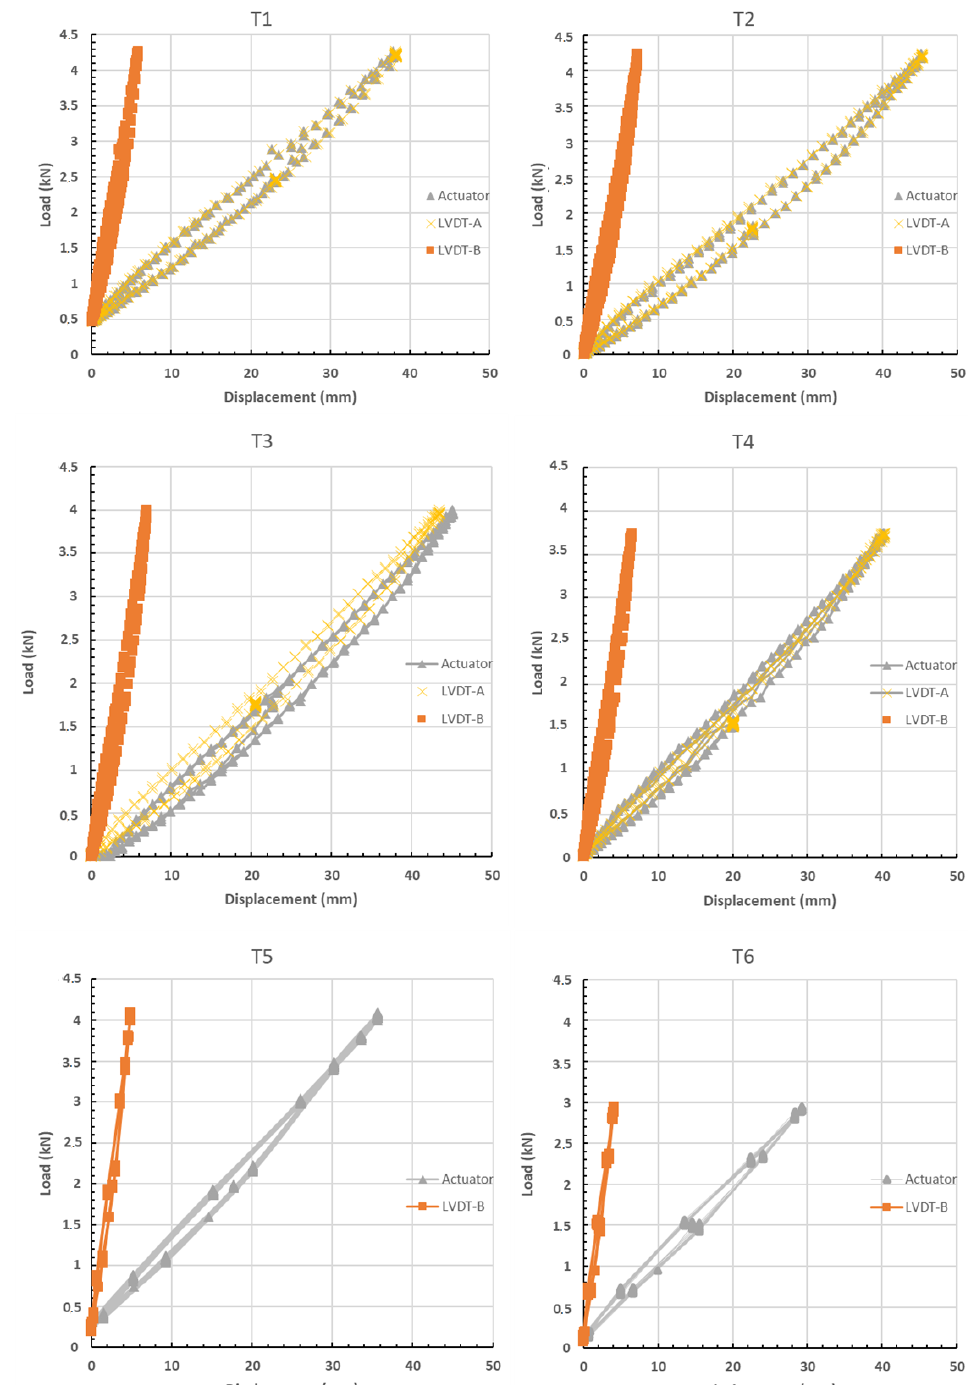
Figure 9. Load – displacement hysteresis curves at variable amplitude loading. Figure 9. Load–displacement hysteresis curves at variable amplitude